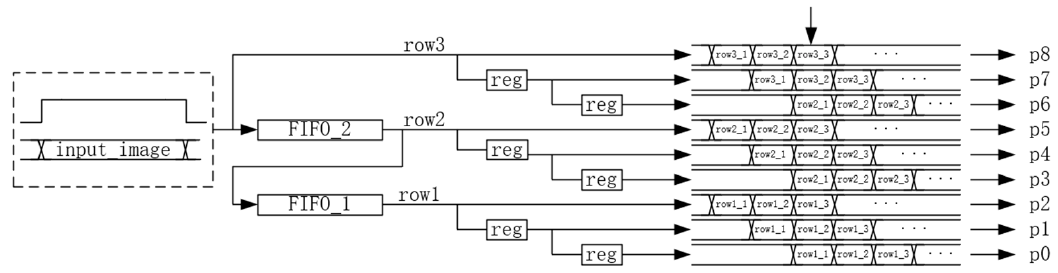
Figure 4. Architecture of Line Buffer.